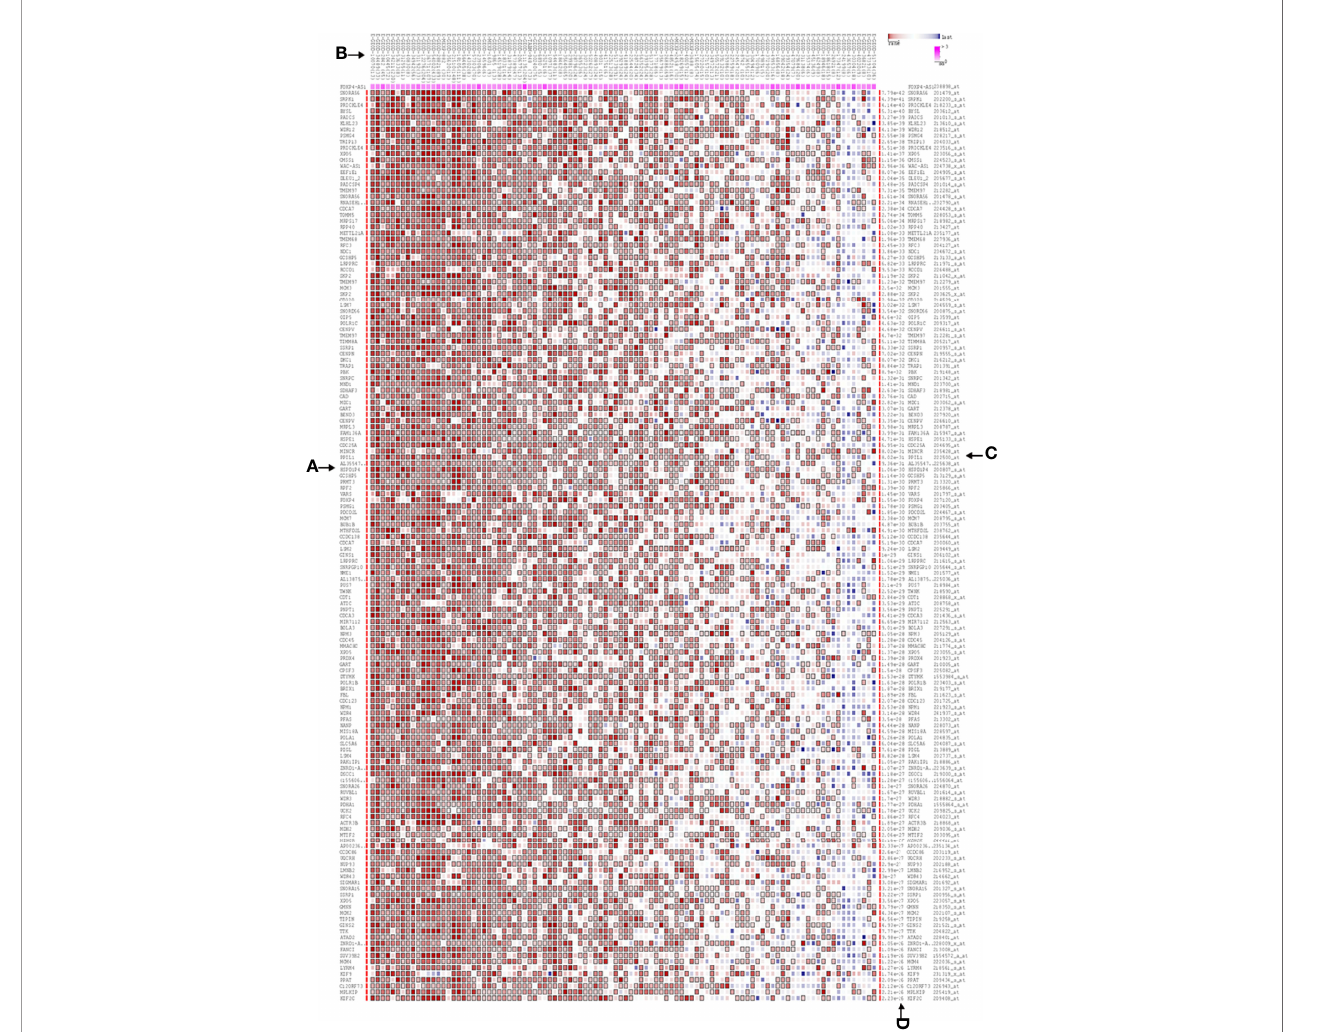
FIGURE 8 | The top 150 predicted target genes of FOXP4-AS1 by using Multi Experiment Matrix (MEM, http://biit.cs.ut.ee/mem/) website. (A) predicted target genes; (B) Single experimental data set; (C) Gene probes; (D) P